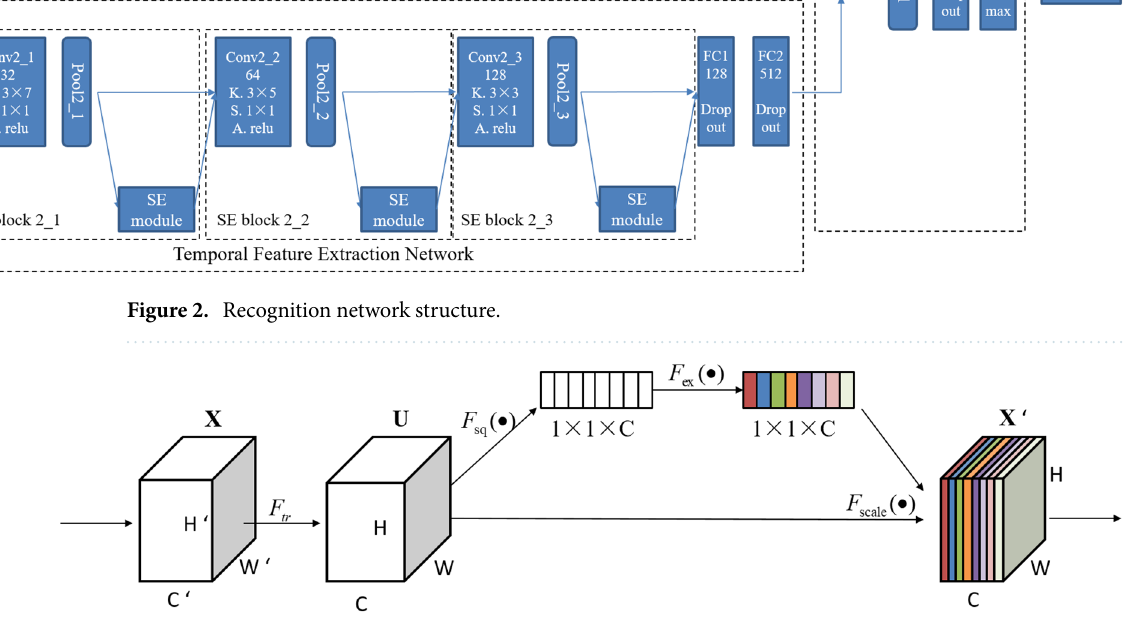
Figure 3. A squeeze-and-excitation